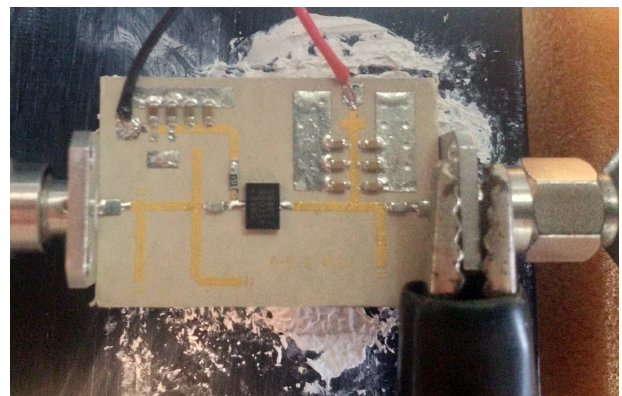
Figure 7. Photo of the realized class-C-F PA.